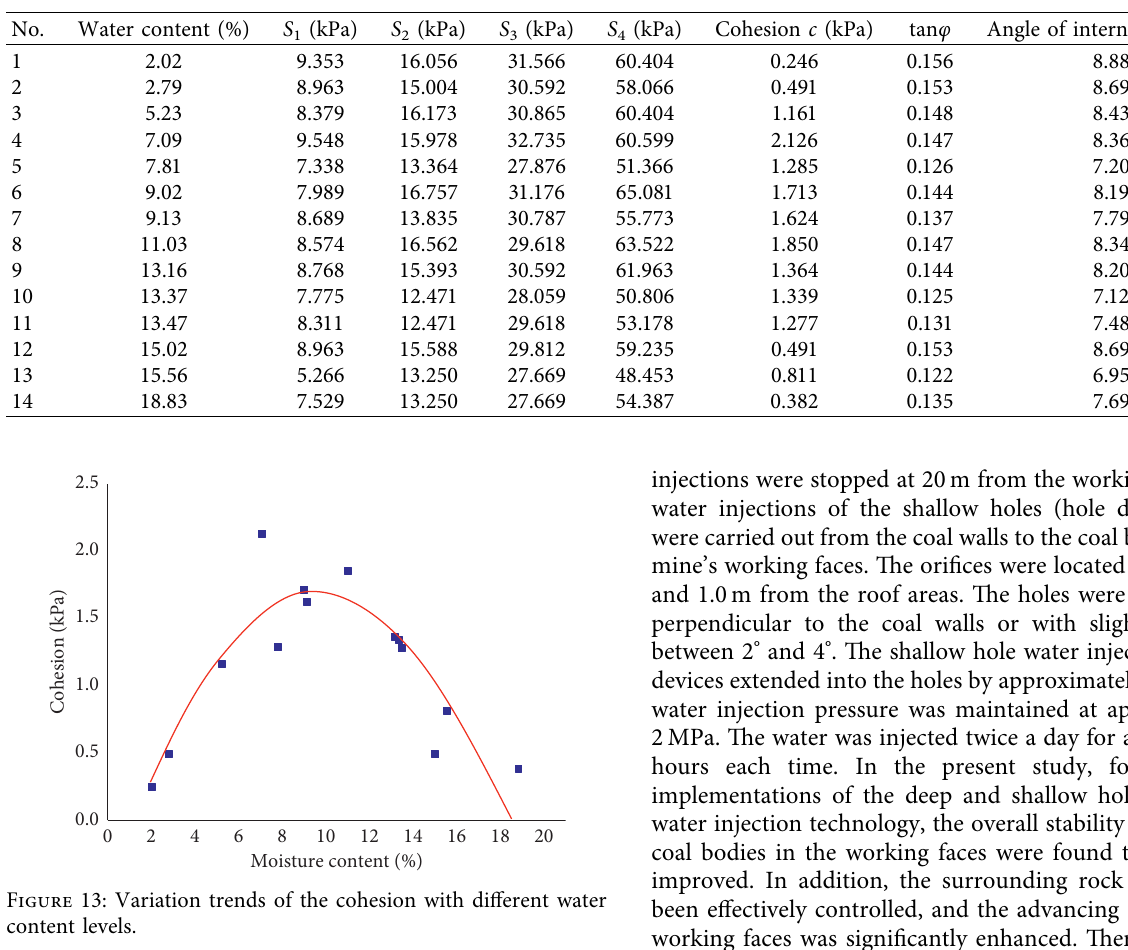
Table 5: Shear strength index under different moisture content conditions.